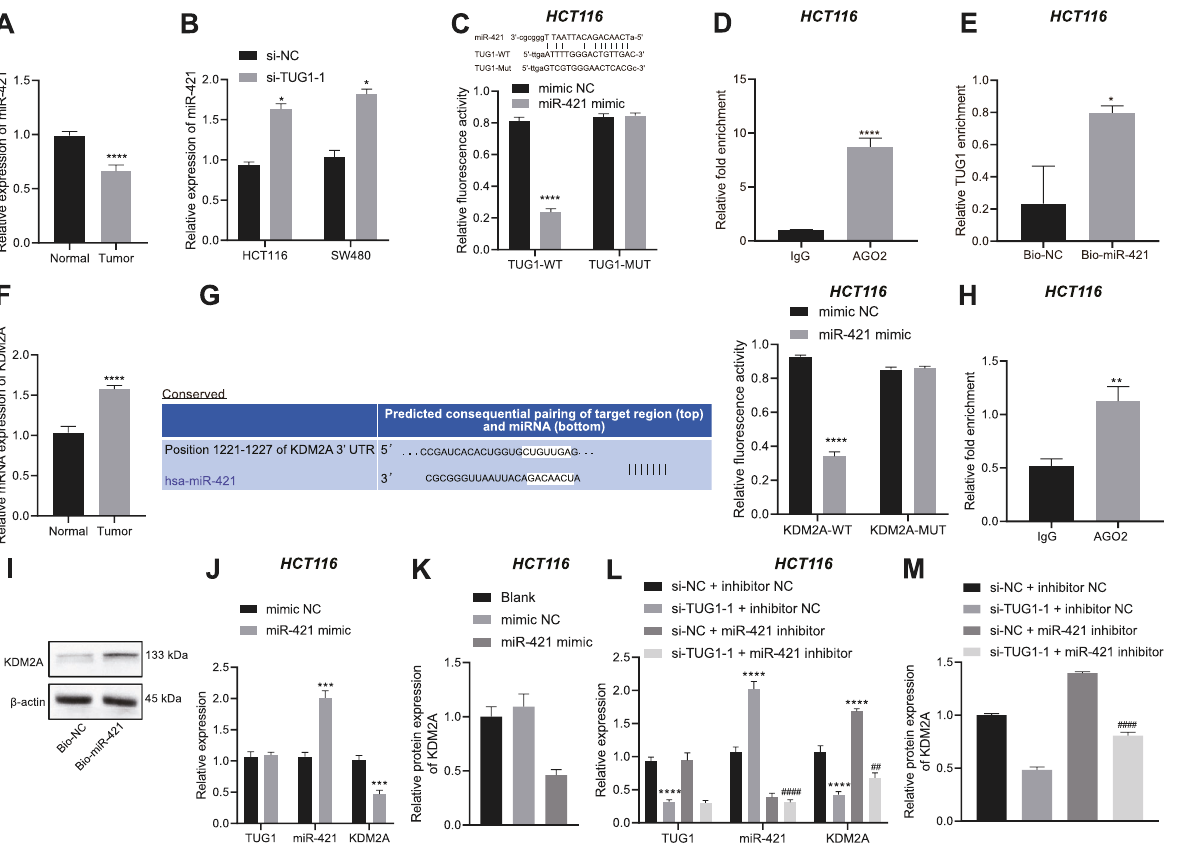
Fig. 3 TUG1 positively regulates KDM2A by binding to miR-421 in HCT116 cells. A Determination of miR-421 expression in the CRC and adjacent normal tissues ( n = 20) by RT-qPCR. B Determination of miR-421 expression in HCT116 and SW480 cells transfected with si-TUG1-1 by RT-qPCR. C The binding of TUG1 to miR-421 in HCT116 cells veri fi ed by dual-luciferase reporter assay. D The binding of TUG1 to miR-421 in HCT116 cells tested by RIP assay in combination with qPCR. E The binding of TUG1 to miR-421 in HCT116 cells tested using RNA pull-down. F Determination of KDM2A expression in the CRC and adjacent normal tissues ( n = 20) by RT-qPCR. G The binding between miR-421 and KDM2A in HCT116 cells identi fi ed using dual-luciferase reporter assay. H The binding of miR-421 to KDM2A in HCT116 cells tested by RIP assay in combination with qPCR. I The binding of miR-421 to KDM2A in HCT116 cells tested using RNA pull-down. J Determination of TUG1, miR-421 and KDM2A expression in HCT116 cells transfected with miR-421 mimic by RT-qPCR. K Measurement of KDM2A protein level in HCT116 cells transfected with miR-421 mimic by western blot assay. L Determination of TUG1, miR-421 and KDM2A expression in HCT116 cells transfected with si-TUG1-1 or combined with miR-421 inhibitor by RT-qPCR. M Measurement of KDM2A protein level in HCT116 cells transfected with si- TUG1-1 or combined with miR-421 inhibitor by western blot assay. * p < 0.05, ** p < 0.01, *** p < 0.001 and **** p < 0.0001, compared with adjacent normal tissues, HCT116 cells transfected with si-NC, mimic NC or si-NC + inhibitor NC, or HCT116 cells incubated with IgG or Bio-NC. # p < 0.05, ## p < 0.01, and #### p < 0.0001, compared with HCT116 cells transfected with si-TUG1-1 + inhibitor NC. The measurement data are expressed as mean ± standard deviation. The experiments were repeated three times independently. Comparison between two groups was conducted